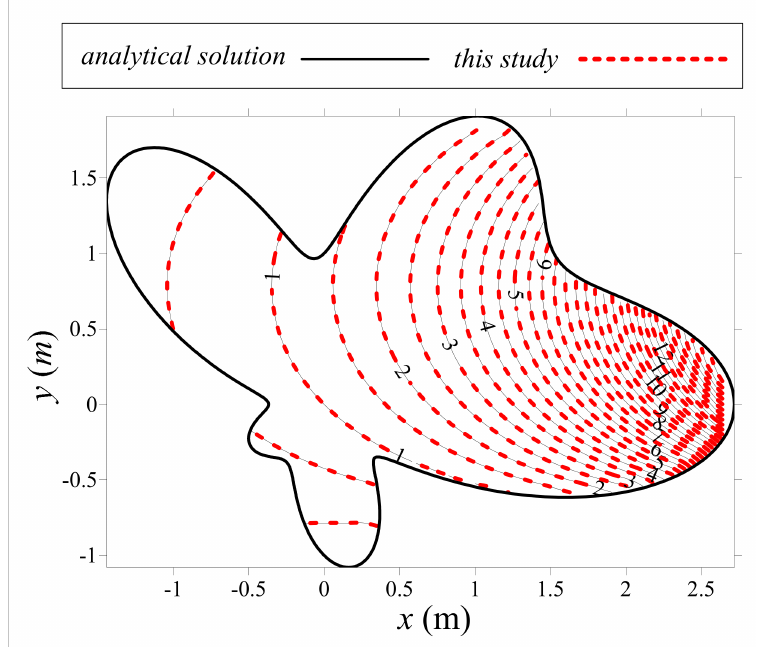
Figure 9. Comparison of the numerical solution with the exact solution.